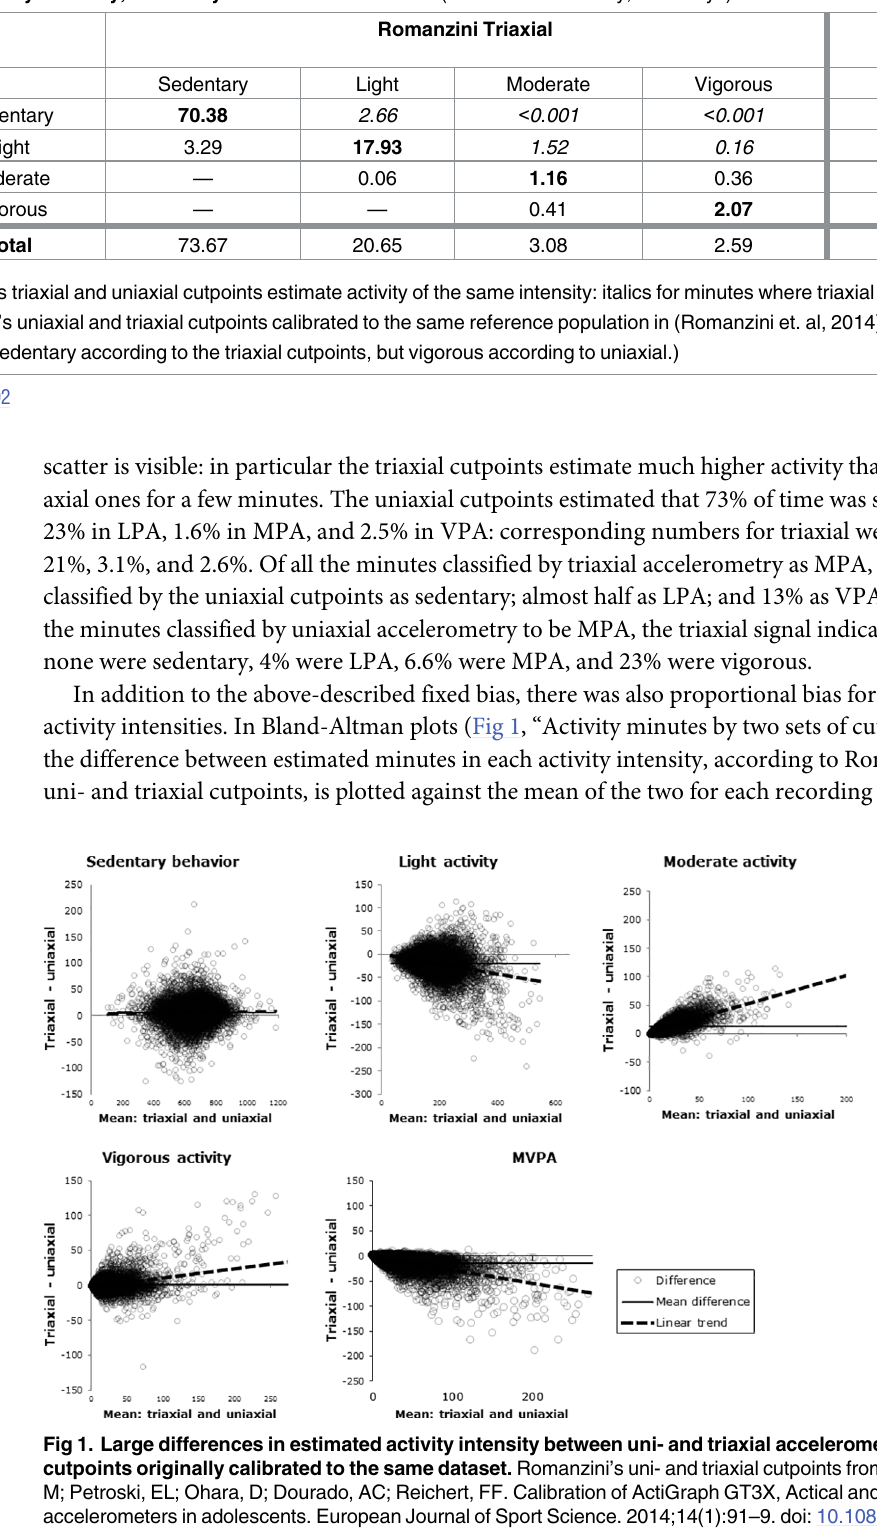
Table 2. Agreement of cutpoints on activity intensity, minute by minute. Percent of time (total 14.7 hours / day, 8780 days).